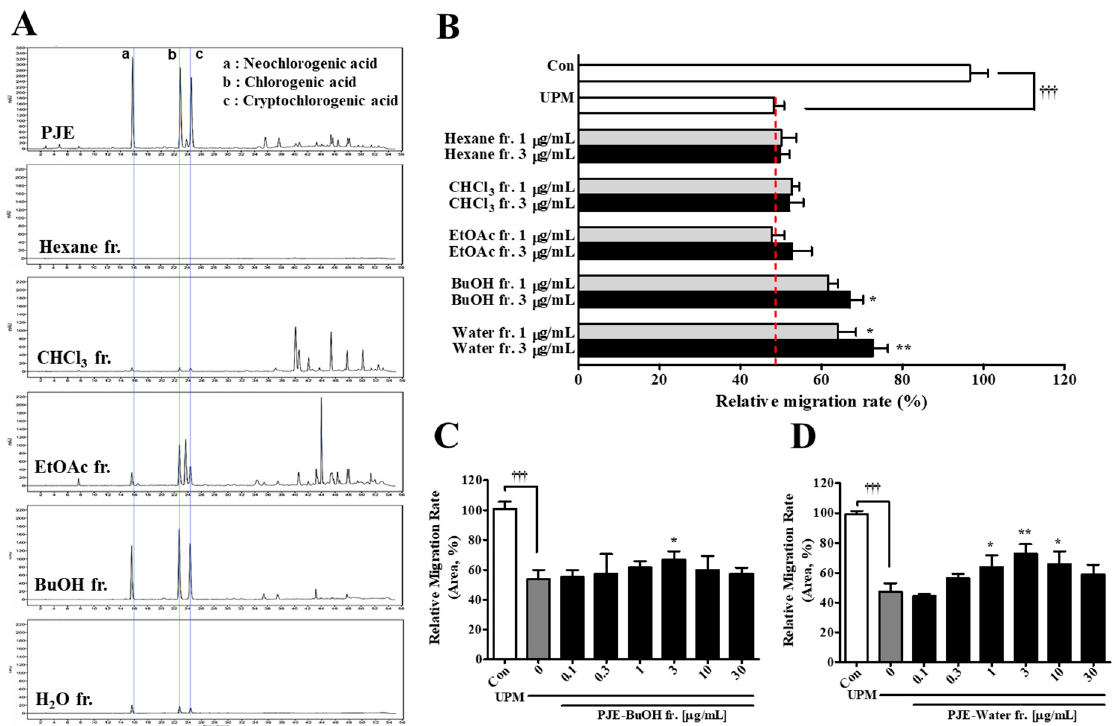
Figure 9. Fractions of PJE after solvent fractionations and their effects on HCEC wound healing. ( A ) HPLC chromatograms of the PJE and its fractions. ( B ) The migration rates of each fraction were calculated, and data from the concentrations of 1 μ g/mL and 3 μ g/mL are presented as the means ± SD. ( C ) The migration rates of the ( C ) BuOH fraction and ( D ) water fraction are presented as the means ± SD. ††† p < 0.001 compared to Con; * p < 0.05, ** p < 0.01 compared to 0 μ g/mL PJE.